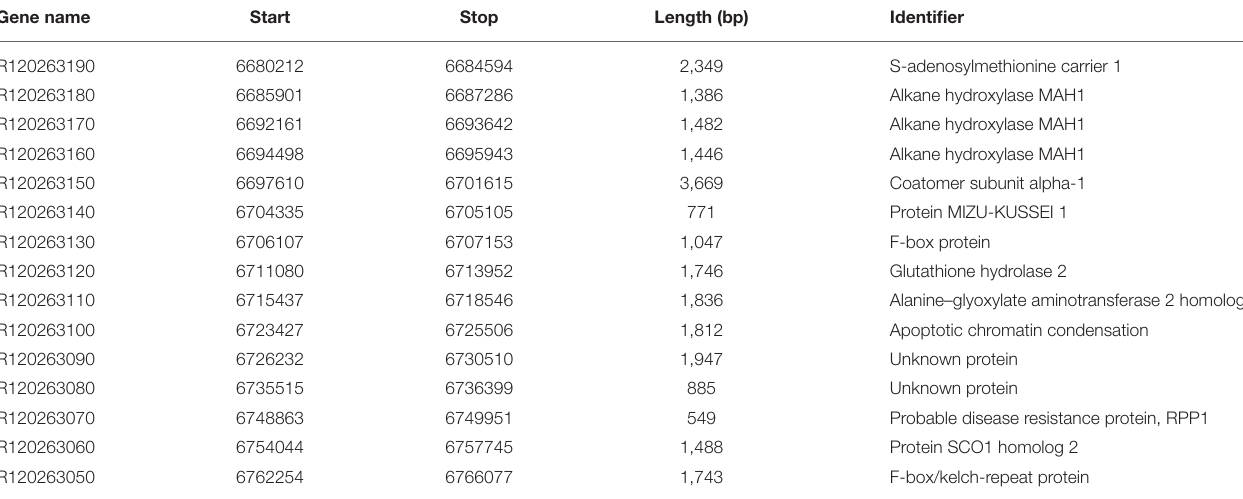
TABLE 2 | Characteristics of 15 predicted genes between molecular markers HB321 and